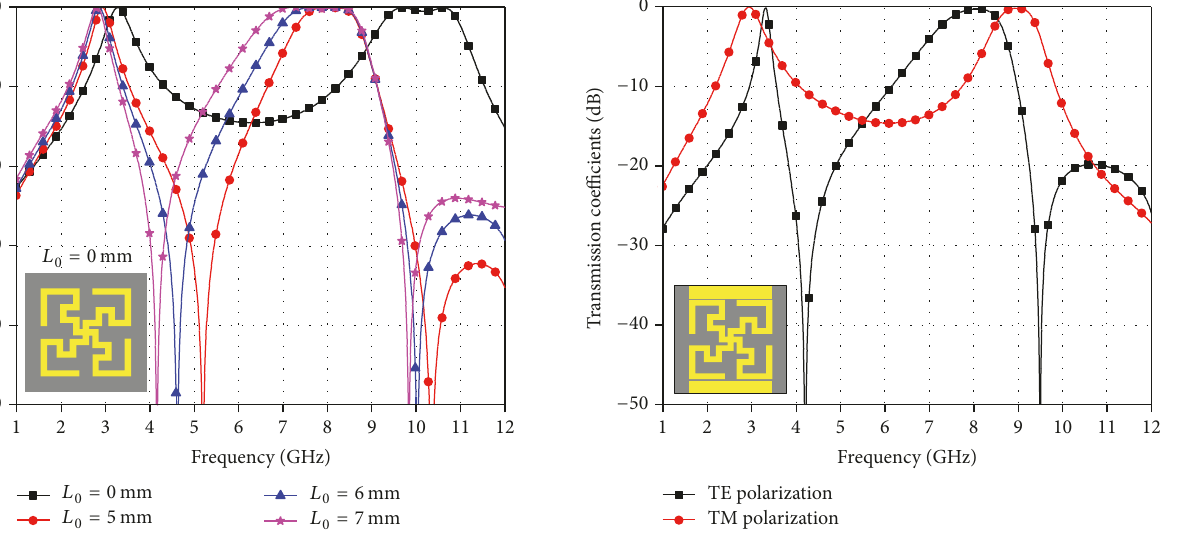
Figure 7: Transmission coefficients of the dual-band FSS with the slots etching in horizontal